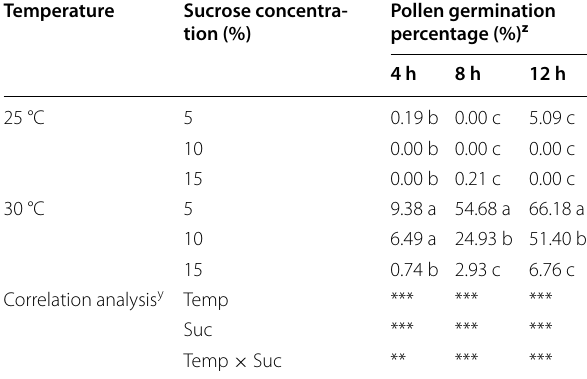
Table 2 In vitro germination of fresh L. callosum pollen on the BK medium with different sucrose concentrations and under different temperatures